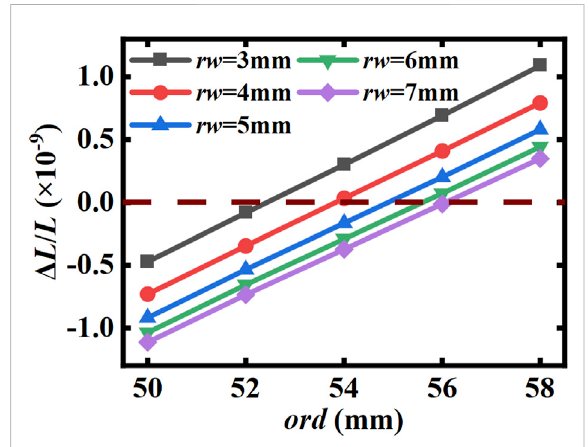
Relationship between the O-ring size and the relative axial displacement of the mirror center for different lateral ring widths with a cover ring thickness of 2 mm of the “ lantern ring ”